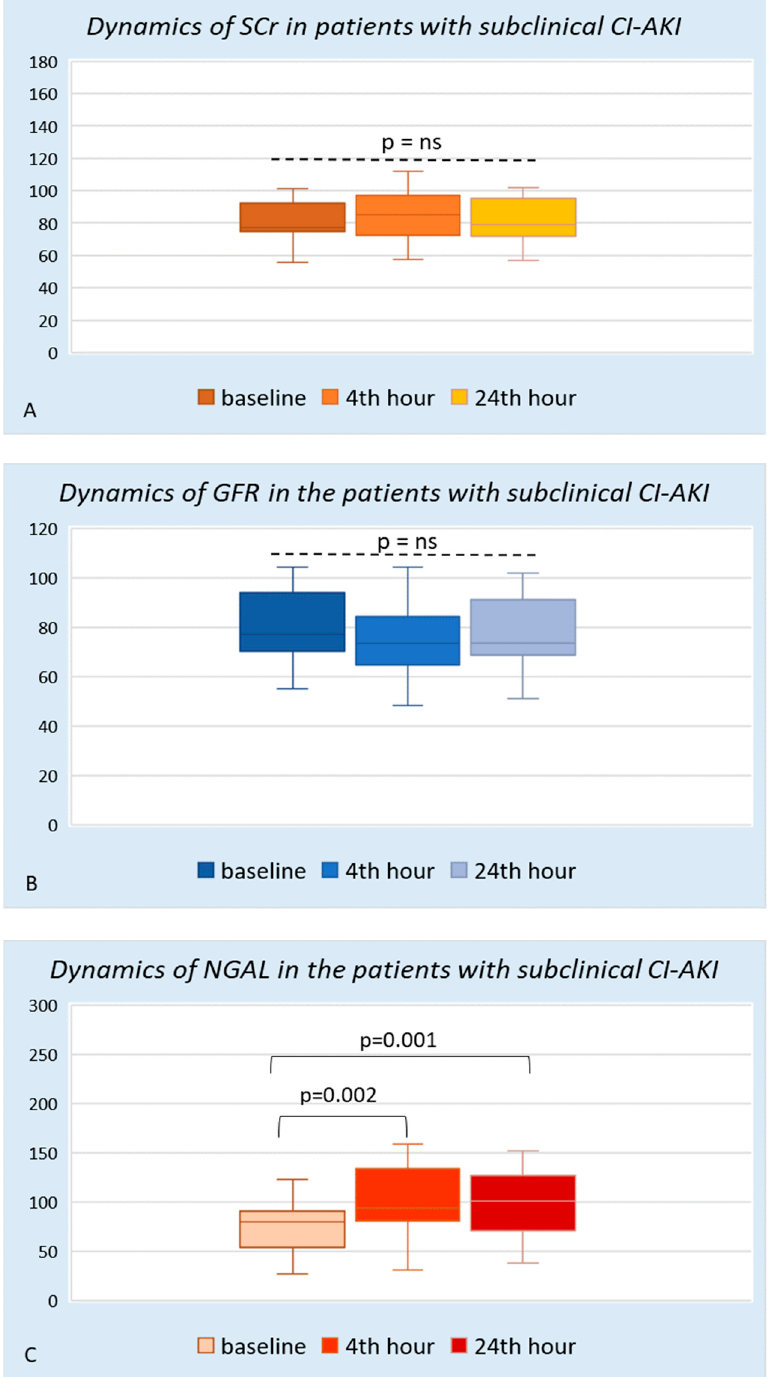
Figure 2. Dynamic changes of all biomarkers in the group of patients with subclinical contras-induced acute kidney injury (CI-AKI). Panel ( A )—dynamics of serum creatinine; Panel ( B )—dynamics of GFR; Panel ( C )—dynamics of NGAL. SCr—serum creatinine ( µ mol/L); GFR—glomerular filtration rate (mL/min/1.73 m 2 ); NGAL—neutrophil gelatinase associated lipocalin (ng/mL). ns—non signi fi cant.